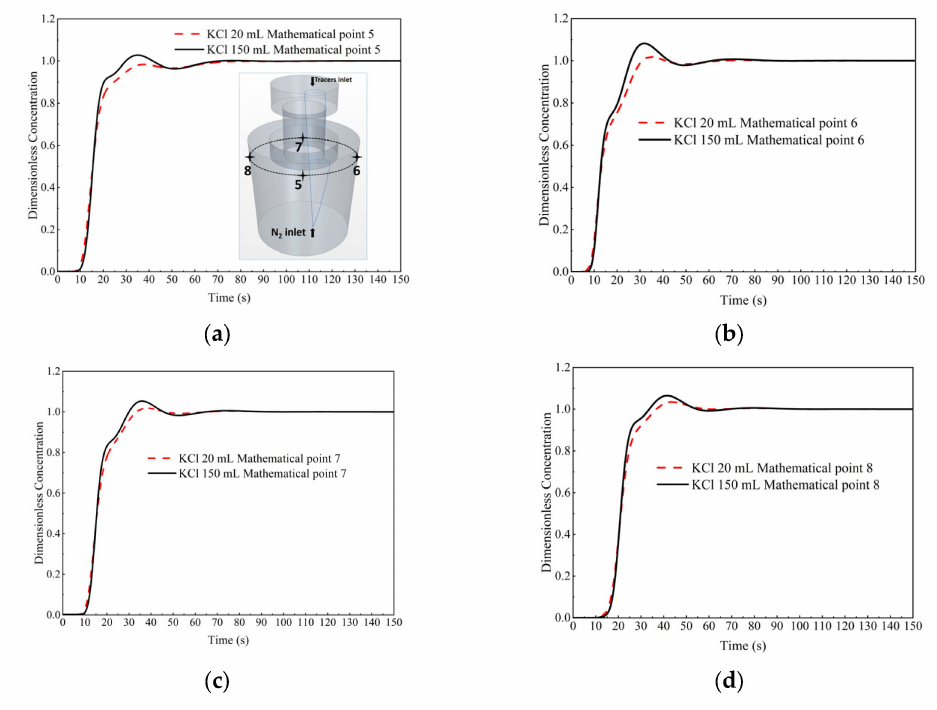
Figure 16. Comparison of the dimensionless concentration-time curves between the case of 20 mL KCl tracer and the case of 150 mL KCl tracer at different monitor locations. ( a ) Monitor point 5, ( b ) Monitor point 6, ( c ) Monitor point 7, and ( d ) Monitor point